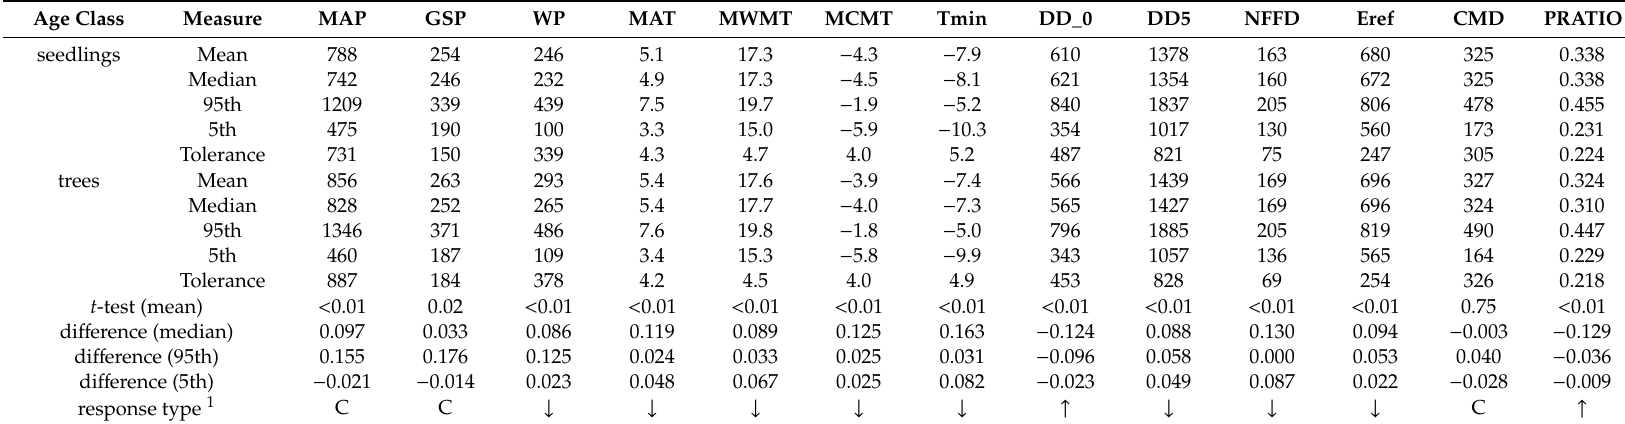
Table 5. Summary of climatic niche data for seedlings and trees including p -values for t -tests of di ff erences in means ( α = 0.05) and values of demographic niche di ff erences ((trees–seedlings) / tolerance trees ). Positive niche values denote variables for which trees have larger values than seedlings. Negative values denote the opposite. Variables are described in Table